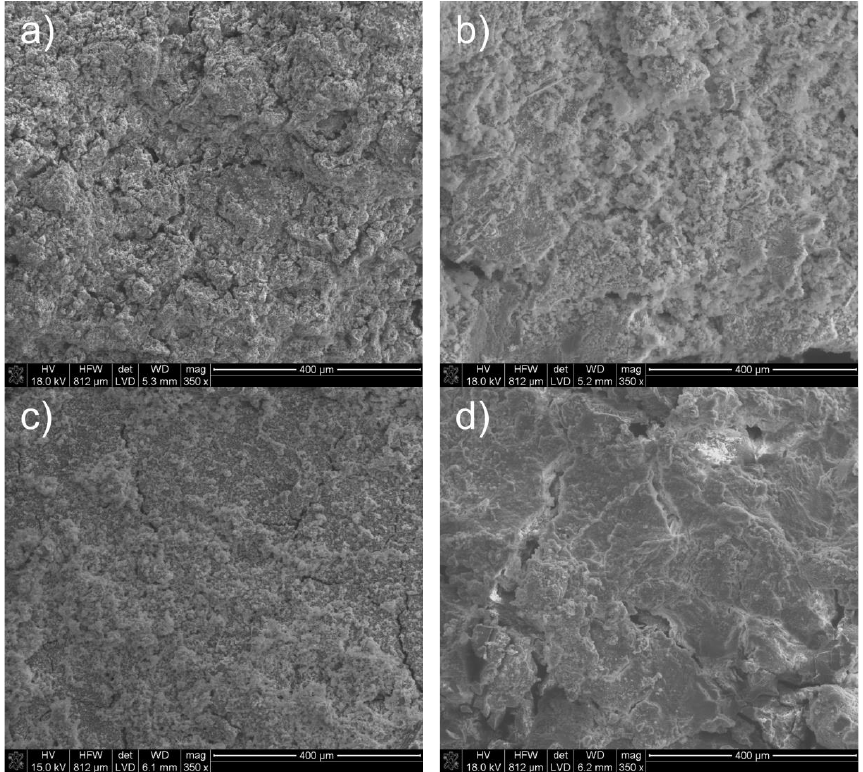
Figure 2. SEM microphotographs of tricalcium aluminate after exposure in ( a ) water (W); ( b ) chicken manure (P); ( c ) pig slurry (G) and ( d ) corn silage (K).